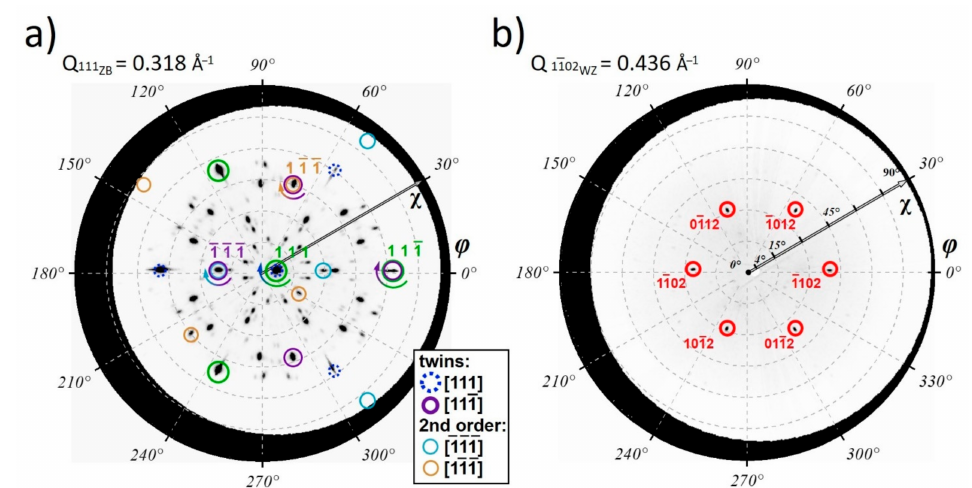
Figure 5. X-ray pole figure maps corresponding to ( a ) ZB-GaP {111} (d = 3.145 Å) and ( b ) WZ-GaP {1102} Bragg reflections (d = 2.294 Å). The modeled reflection positions are shown with coloured circles, gradient colored arrows indicate the formation of rotational twins in